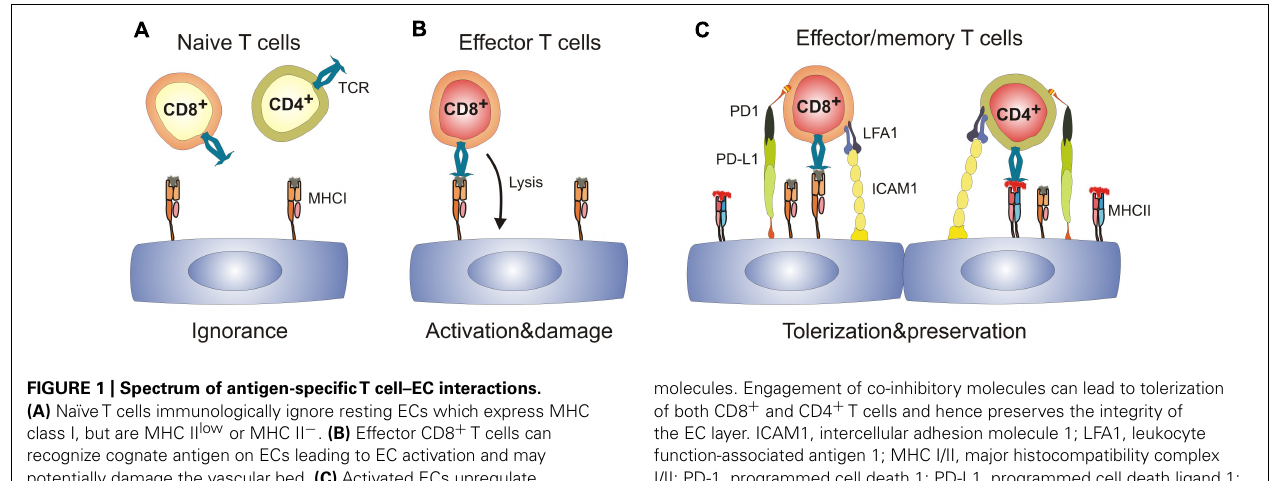
molecules. Engagement of co-inhibitory molecules can lead to tolerization of both CD8 + and CD4 + T cells and hence preserves the integrity of the EC layer. ICAM1, intercellular adhesion molecule 1; LFA1, leukocyte function-associated antigen 1; MHC I/II, major histocompatibility